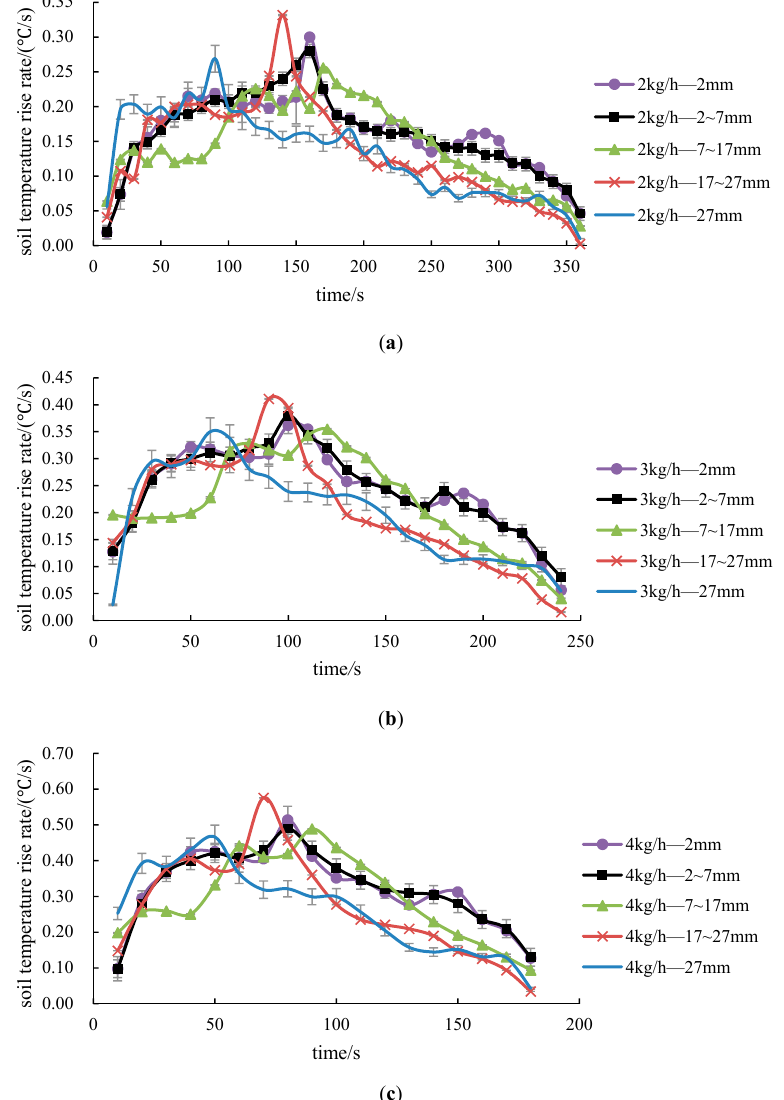
Figure 10. Variation in mean ST rise rate and disinfection time. ( a ) 2 kg/h; ( b ) 3 kg/h; and ( c ) 4 kg/h.